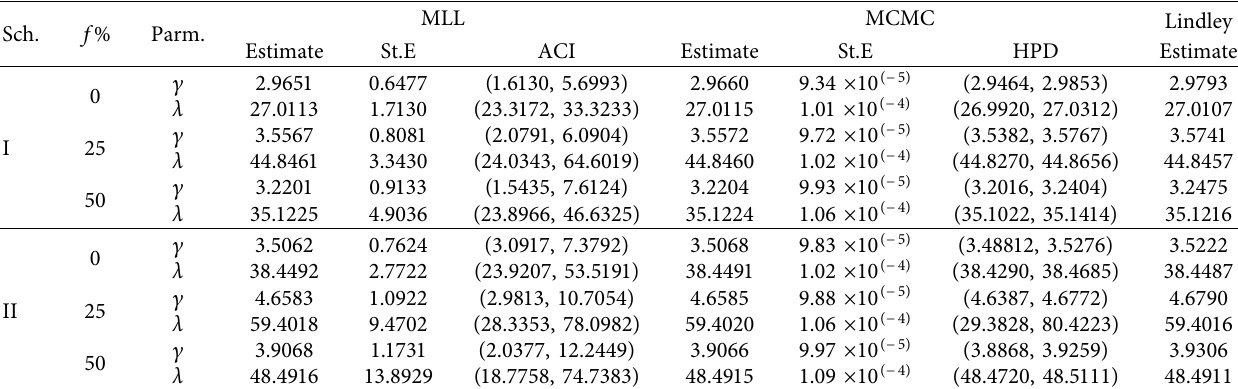
Table 10: MLL, Bayesian, and St.E and ACI based on the PCTI under various censoring schemes for data set II. Sch.